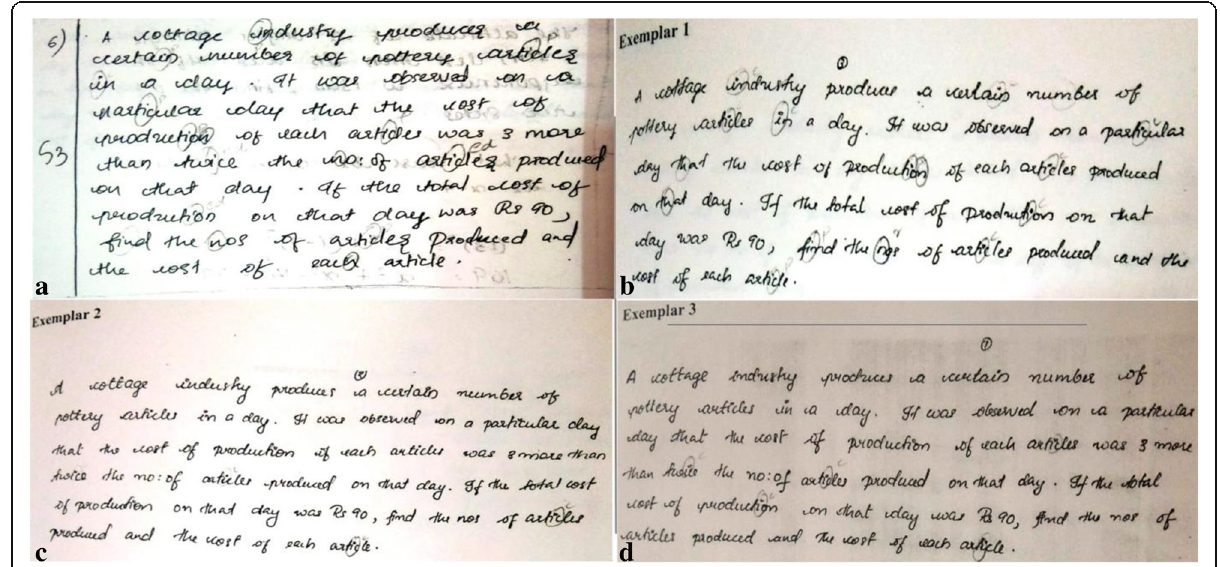
Fig. 1 Admitted and exemplar samples. a Admitted writing, drafted ten years before b, c and d , Exemplar 1, 2, and 3 respectively drafted at present